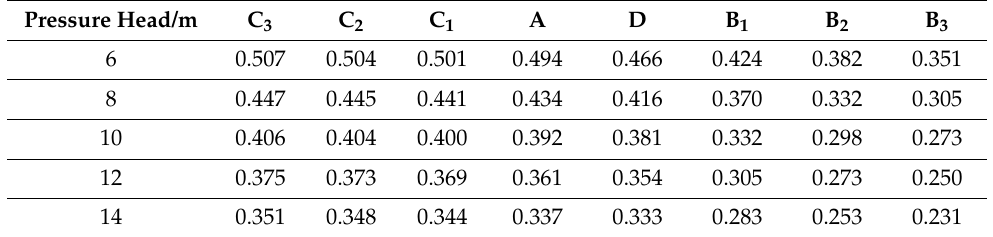
Table 4. The calculation results of the flow rate-pressure curve